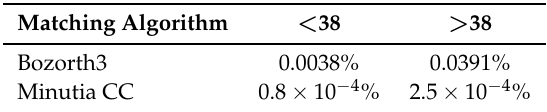
Table 3. Probability value of a successful attack FAR A for the two classes of the number of minutiae for the two matching algorithms.